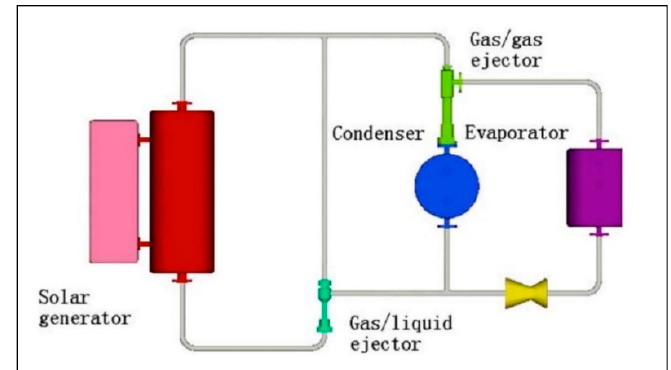
Figure 16. Solar-powered bi-ejector refrigeration system [184].